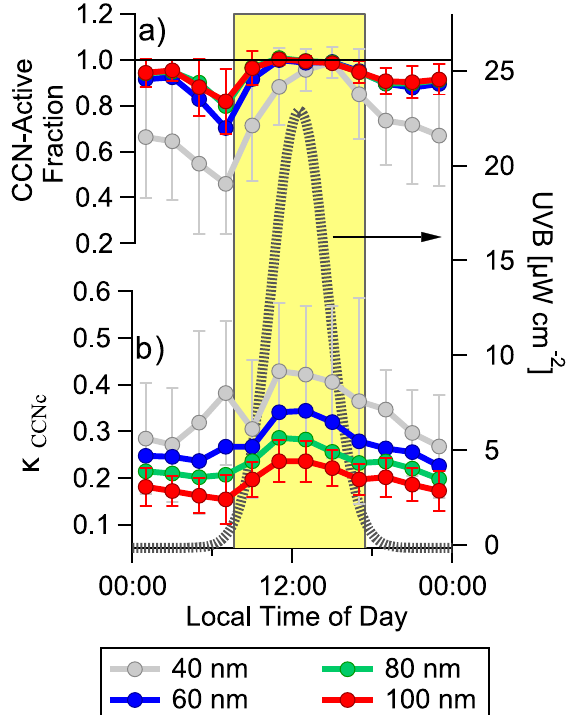
Fig. 1. Campaign average diurnal profile of measured mixing-state properties and composition of 40, 60, 80 and 100 nm aerosol during the MIRAGE 2006 campaign: a) fraction of particles acting as CCN at ∼ 1% supersaturation, b) hygroscopicity parameter for the CCN-active fraction. Plotted on the right axis is a Gaussian fit to the average ultraviolet solar intensity (UVB) as a function of the local time of day (UTC - 6 h) during MIRAGE 2006, with the daylight hours between 07:36 and 17:27 ( ± 5 h from solar maximum) highlighted.